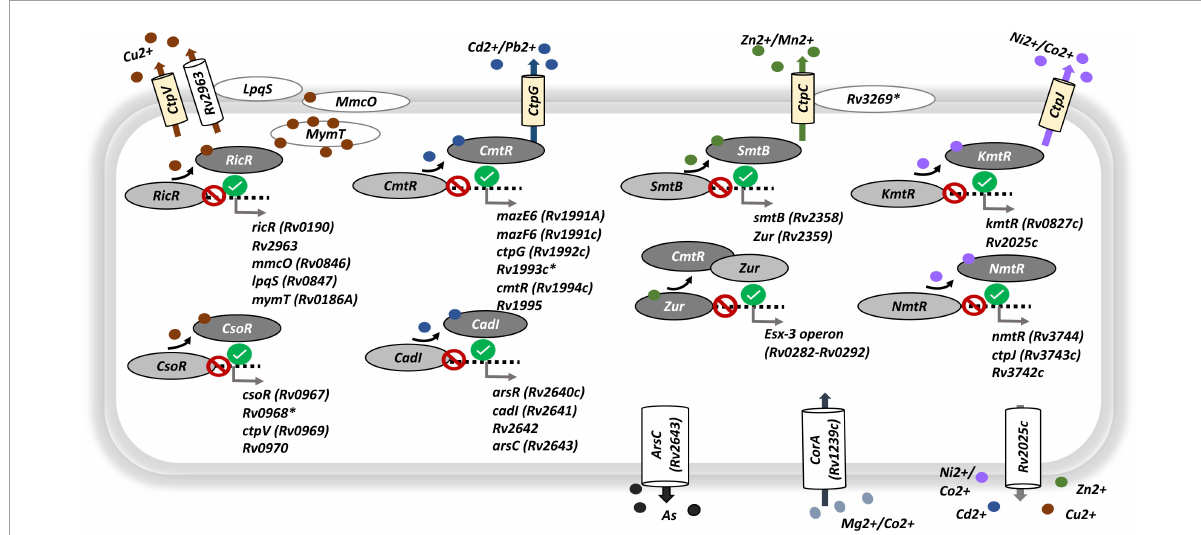
FIGURE5 Genes associated to metal transport and regulation. Circular red and green signals indicate, respectively, the repression or activation of the corresponding regulatory gene-target in response to growth arrest being enhanced by iron deprivation [interaction, contrast (v)]. Light yellow barrel boxes, cation-transport ATPases type-P; white barrel and oval boxes, transmembrane proteins, membrane proteins or ions canals; light oval gray, repressor linked to related promoter region; dark oval gray, metal-repressor complex separated from related promoter region; small dense circles, different metals, each metal was represented by different color. Black: upregulated responses to interaction (EU genes). See Supplementary Table 4 for gene expression